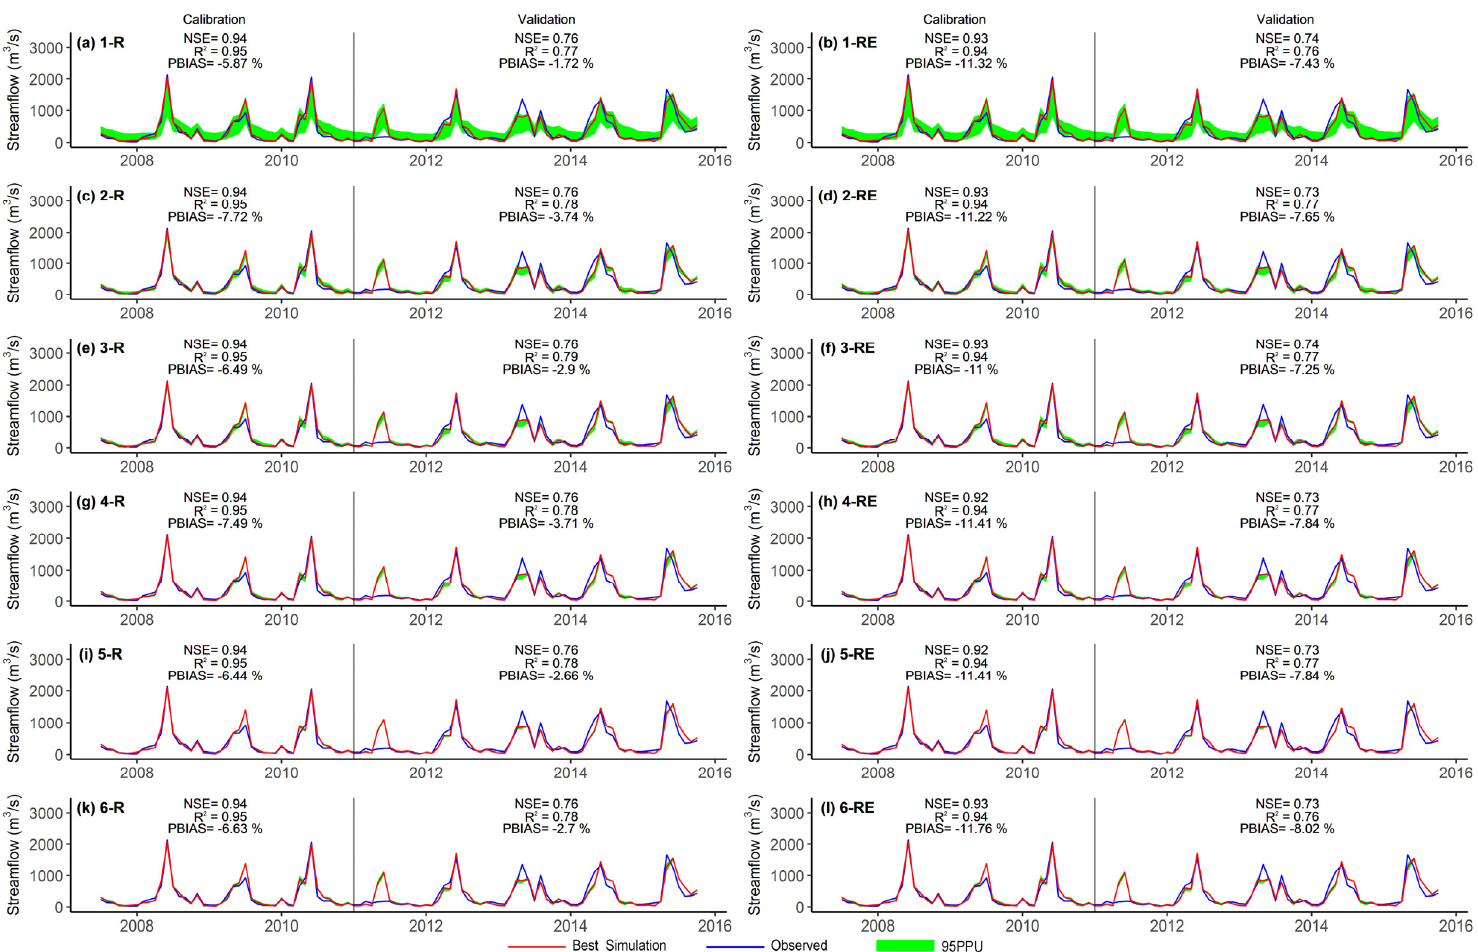
Figure 3. Calibration and validation of SWAT in simulating streamflow at Zhaoping gaging station using observed streamflow data only (the left panel) and observed streamflow plus remotely-sensed ET (the right panel). The definition of scenario codes (e.g., 1-R, 1-RE, etc.) marked on the upper left corner of each panel can be referenced to Table 2. ( a – l ) were the codes of 12 scenarios.